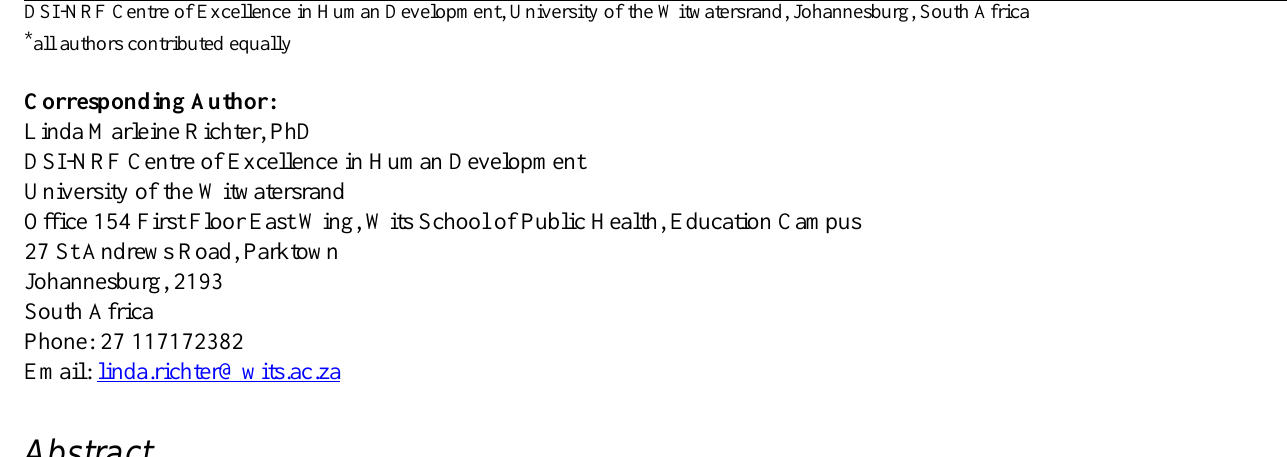
families; parenting; children; COVID-19; digital; survey;